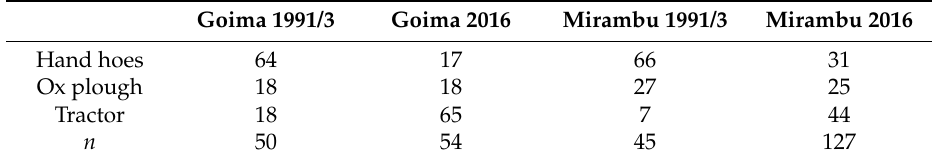
Table 3. Mode of cultivation (%) in Goima and Mirambu villages, 1991/3 (farmers) and 2016 (plots).